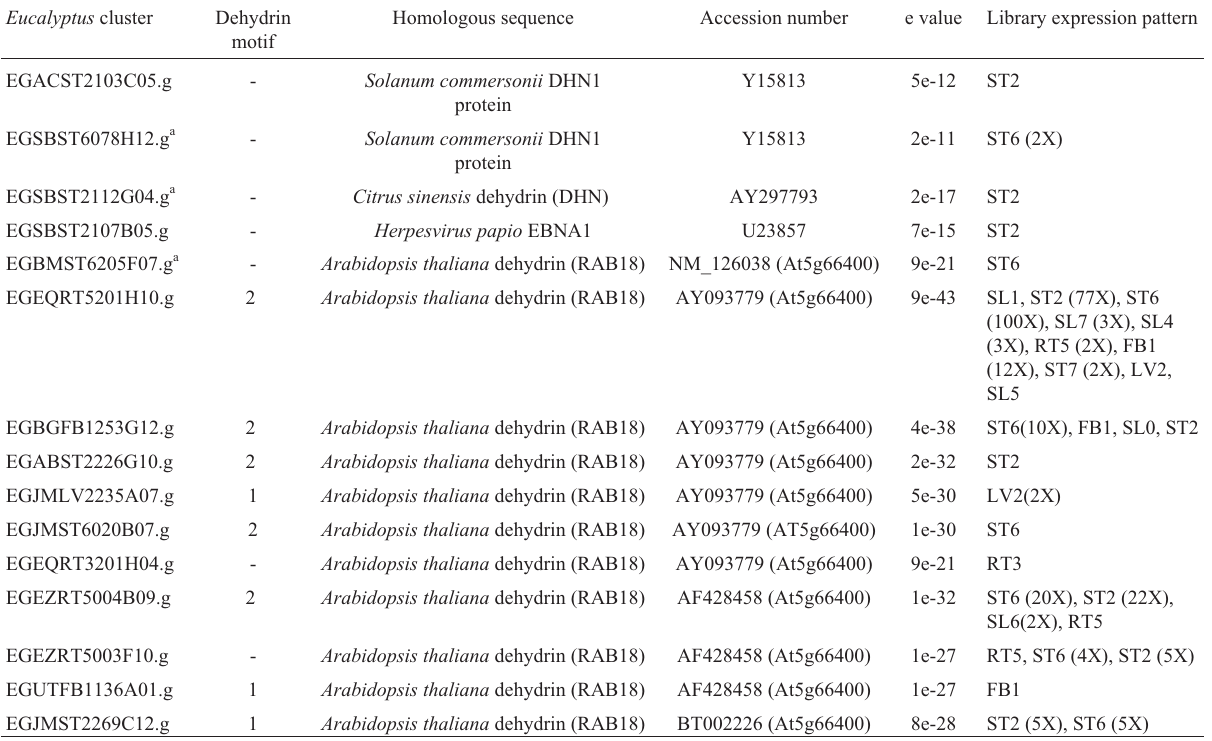
Table 7 - Eucalyptus ESTs encoding GRPs with similarity to dehydrin. Eucalyptus